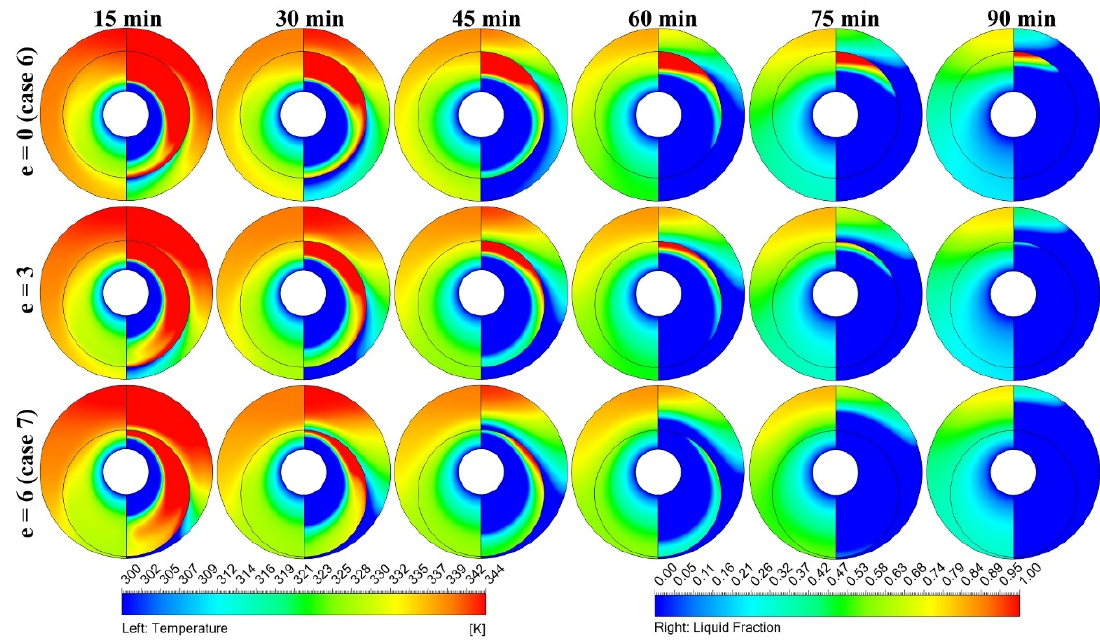
Figure 12. Histories of liquid fraction ( right halves ) and temperature distribution ( left halves ) for